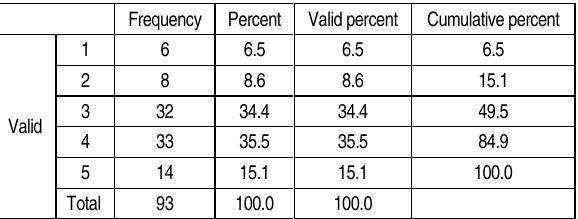
Table 6. Competition is a constraint to growth Table 9. Lack of entrepreneurial skills is a challenge